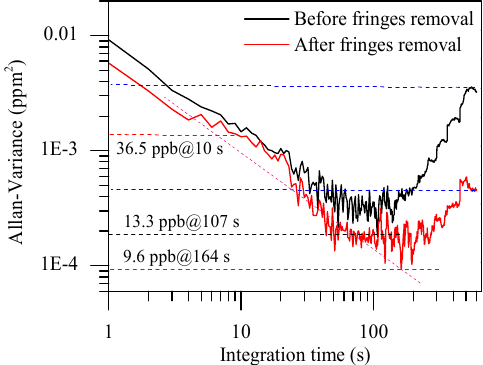
Figure 6. Comparison of Allan variance of the sensor before and after fringes removal.